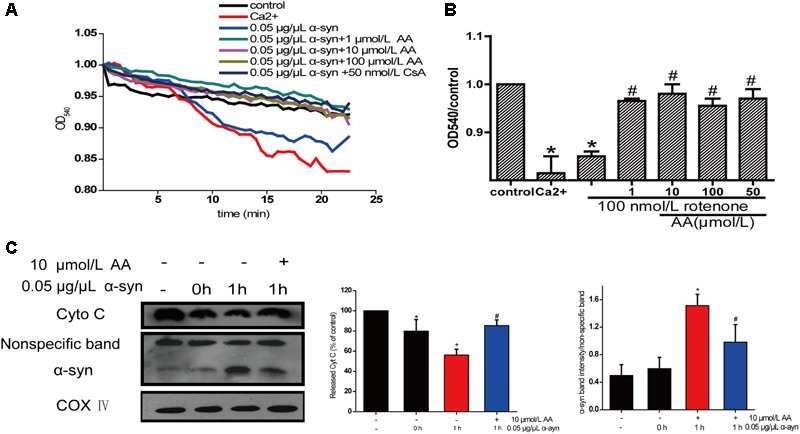
Neuroprotective effects of AA against α-syn-induced injury in isolated mitochondria. Isolated mitochondria were treated with vehicle or AA for 60 min at 37°C and exposed to 0 or 0.05 μg/μL α-syn at the same time. (A,B) Inhibitory effects of AA on α-syn-induced mitochondrial swelling, which was reflected by the decrease in absorbance at 540 nm and the results were statistics at the endpoint of the experiment. (C) AA reverses α-syn-induced release of cyt C from mitochondria and mitochondrial translocation of α-syn. Data are expressed as means ± SD, n = 3. ∗p < 0.01 vs. control group, #p < 0.01 vs. α-syn group.